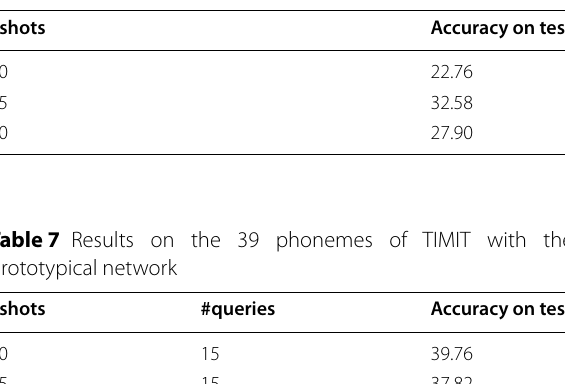
Table 6 Results on the 39 phonemes of TIMIT with the siamese network